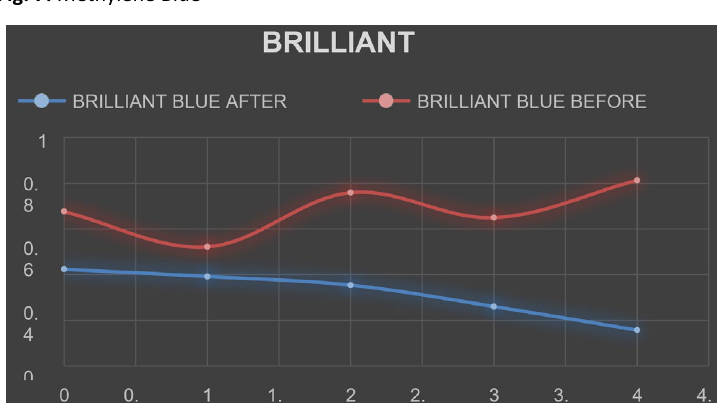
Fig. 7. Methylene Blue